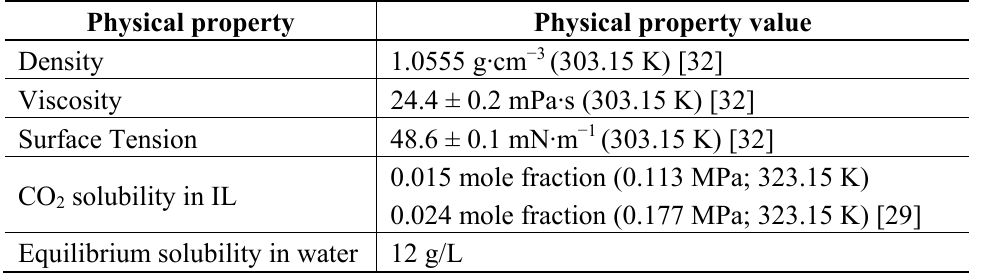
Table 2. Properties of